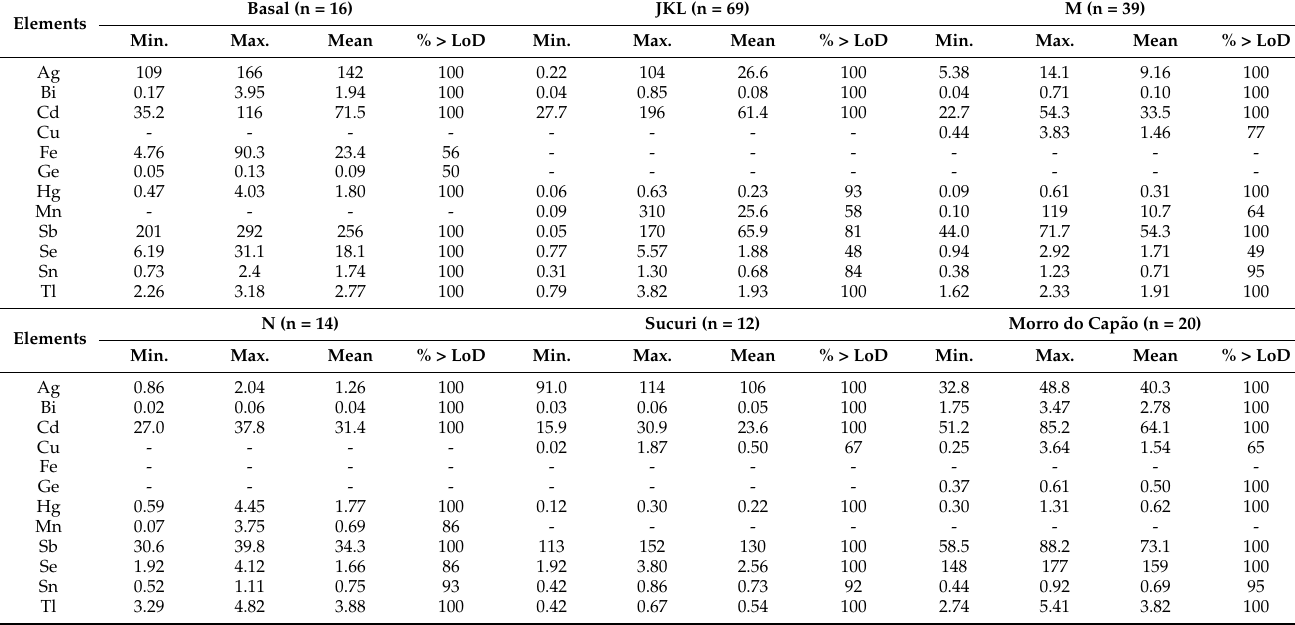
Table 4. Trace element contents of galena determined by LA-ICP-MS from the Morro Agudo district. All units are in ppm.